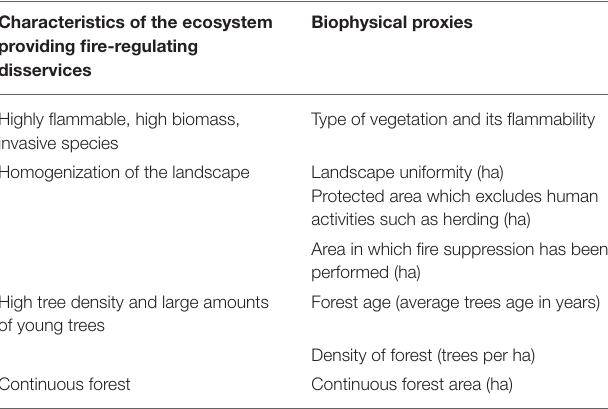
TABLE 3 | List of characteristics of ecosystems that produce fire-regulating disservices and biophysical proxies to assess them. Characteristics of the ecosystem providing fire-regulating